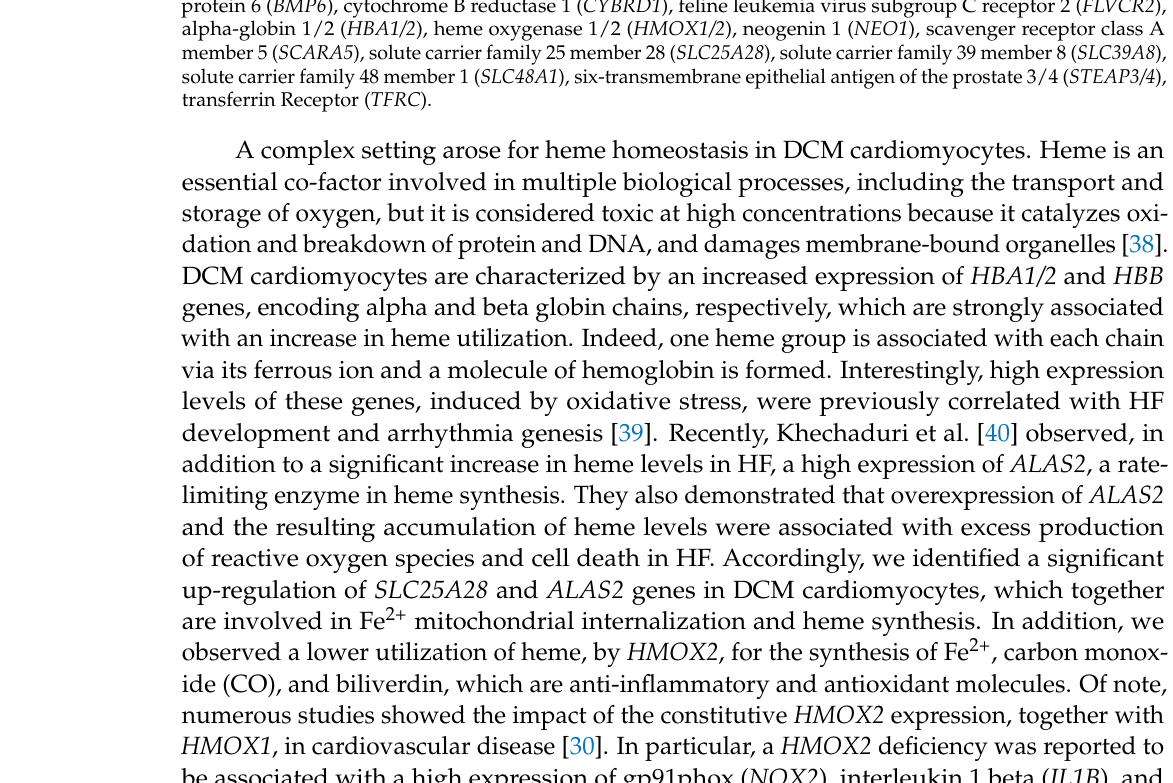
− ↓ − − − Gene symbols were reported together with their function. The upward arrow indicates up-regulation, the downward arrow indicates down-regulation, while the dash means no significant regulation.